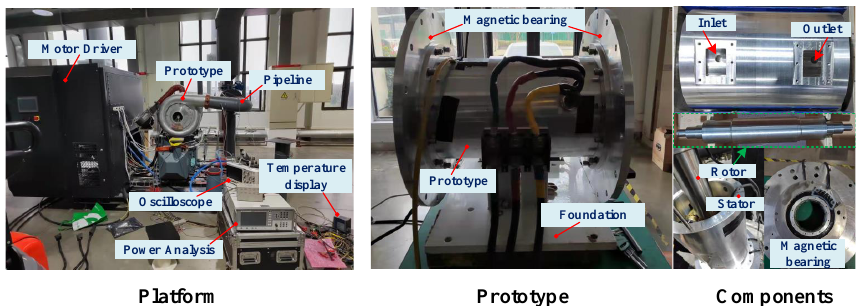
Figure 11. The prototype and test